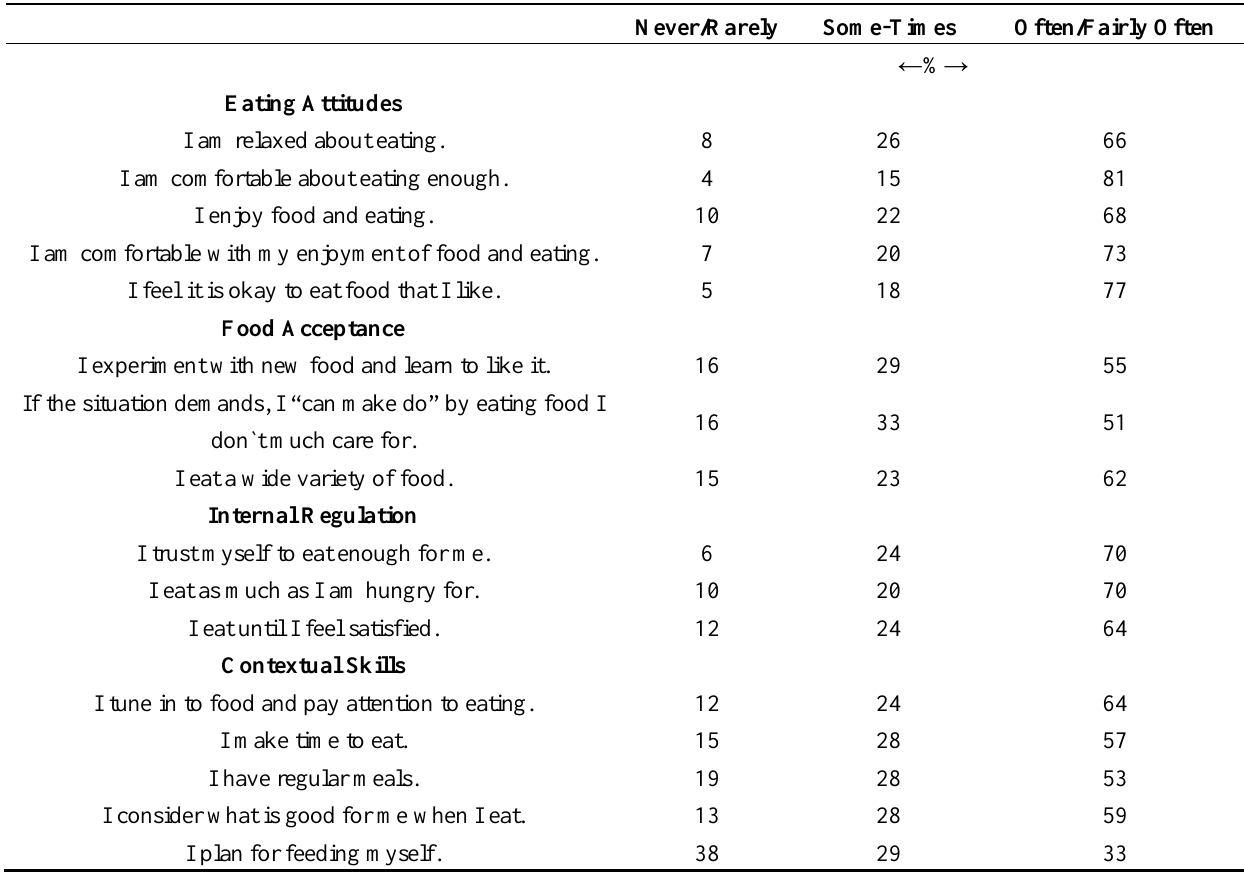
Table 1. Percentage (%) distribution of the adolescents’ responses to the preliminary Finnish translation of the ecSatter Eating Competence Inventory 2.0 ( n = 976). Never/Rarely Some-Times Often/Fairly Often